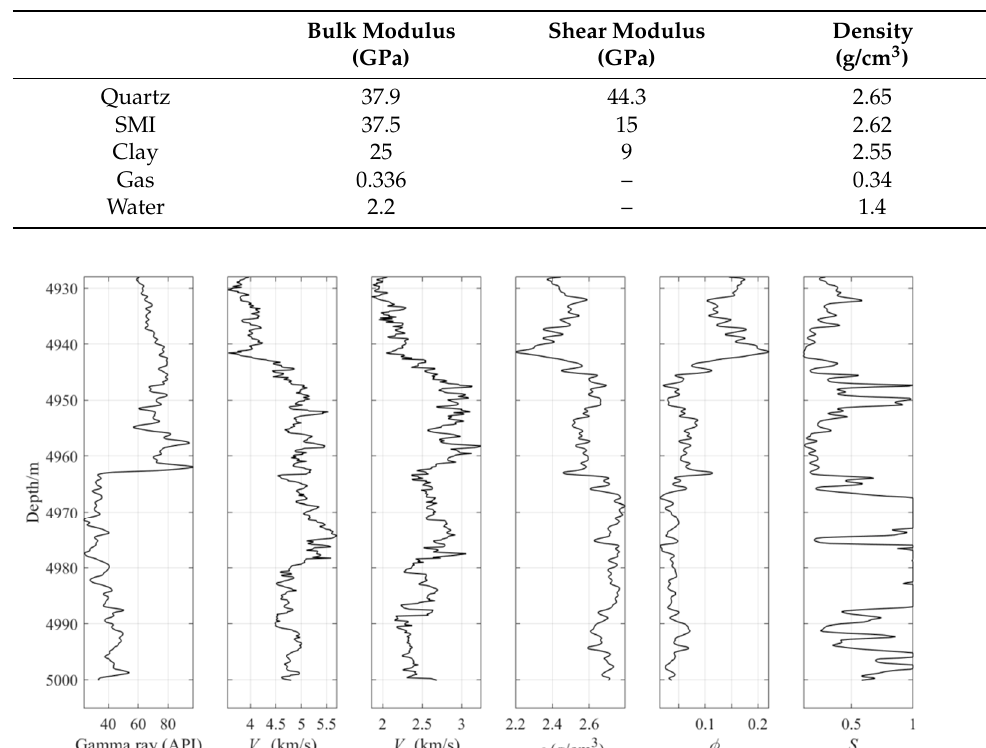
Figure 3. The logging curve of the target well section. Table 1. The modulus and density of mineral and pore fluids [43 ].